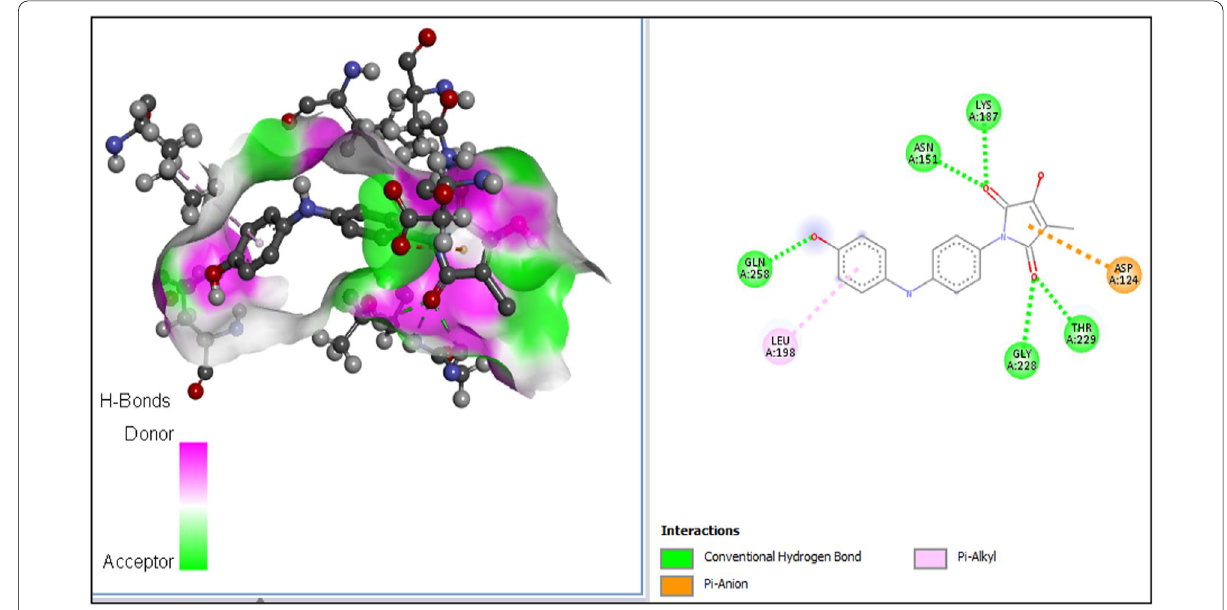
Fig. 9 2D and 3D view of the interaction between N7 and